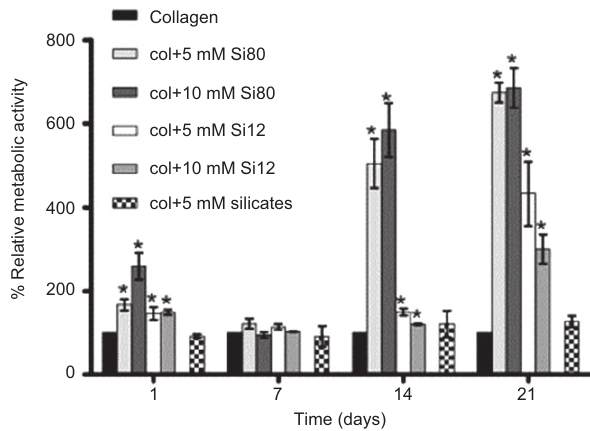
Figure 6 Metabolic activity of entrapped fibroblasts within the col- lagen (control) and silica-collagen composite hydrogels at different incubation times, assessed by MTT assay (*p < 0.05), according to Desimone et al. [21] . Reproduced with permission from